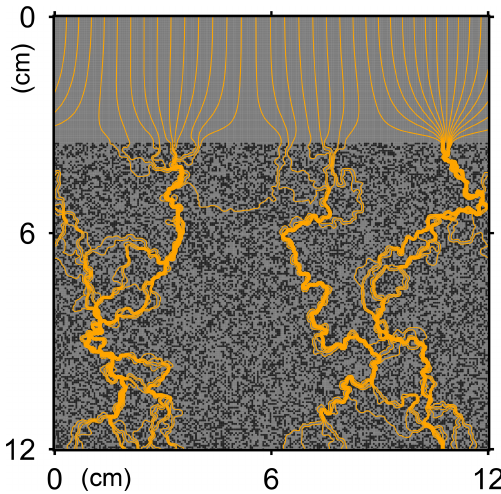
Figure C1. Streamlines for permeability calculation at the begin- ning of simulation (a) in Sect. 3.2.